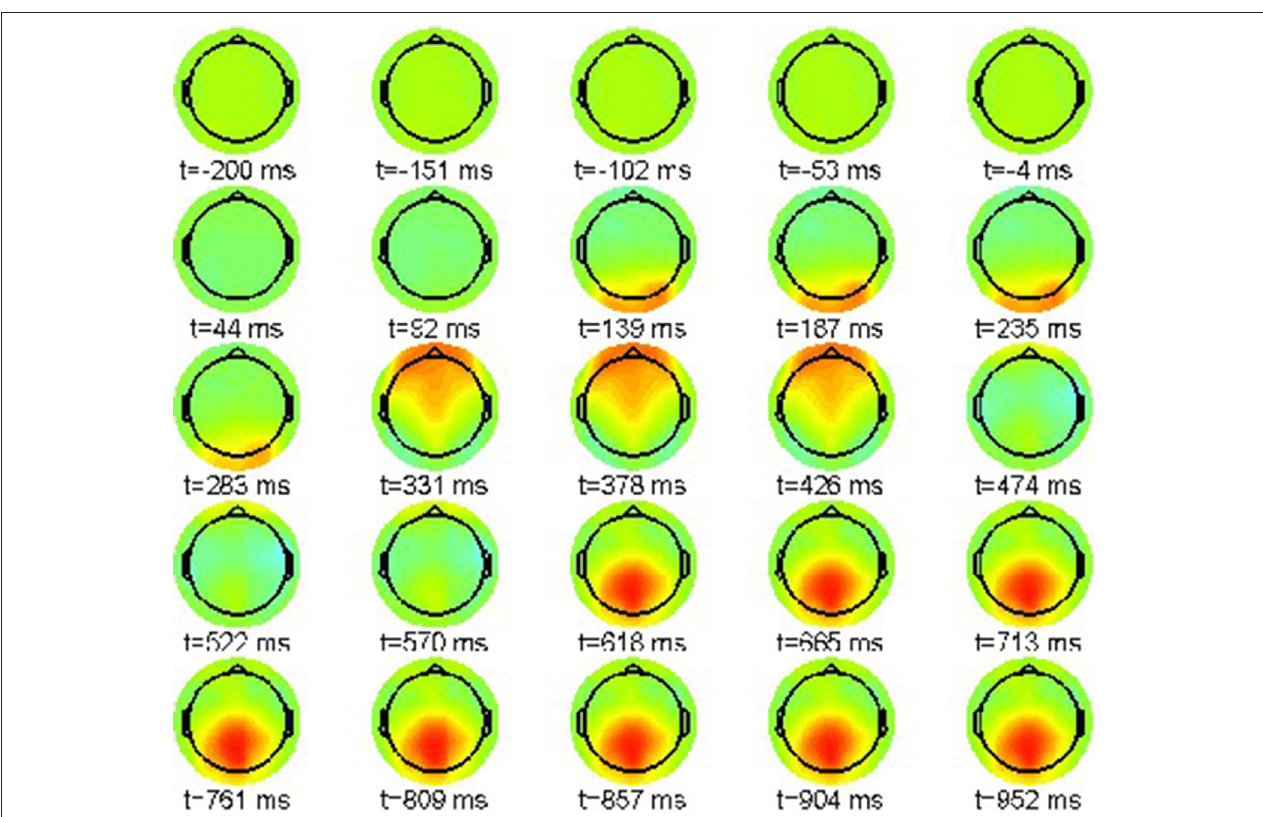
FIGURE 8 | Snapshot sequence of neural field scalp topographies for violation condition (22-b).